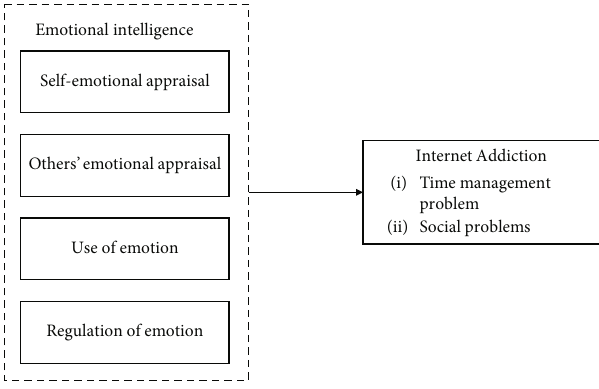
Figure 1: The model of emotional intelligence and internet